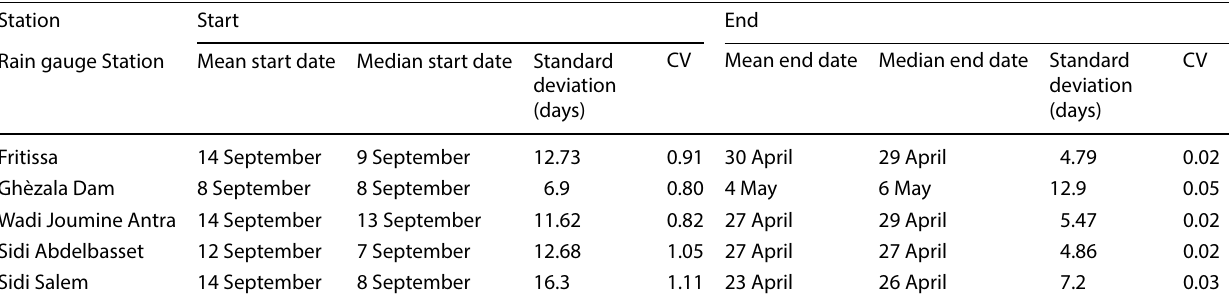
Table 17 Mean and median dates for the start and end of the rainy season in Ichkeul lake basin